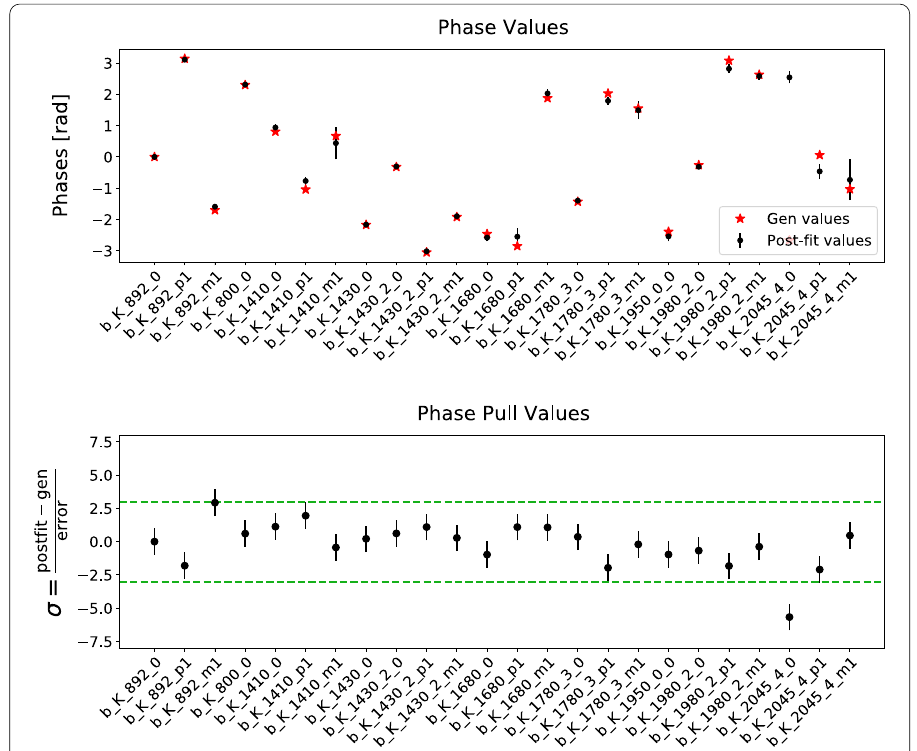
Fig. 6 Comparison of generated and post-fit values of the phase parameters (above) and the corresponding pull distribution (below) obtained from a fit to events generated with all the ten K ∗ resonances. The green lines define a ± 3 σ